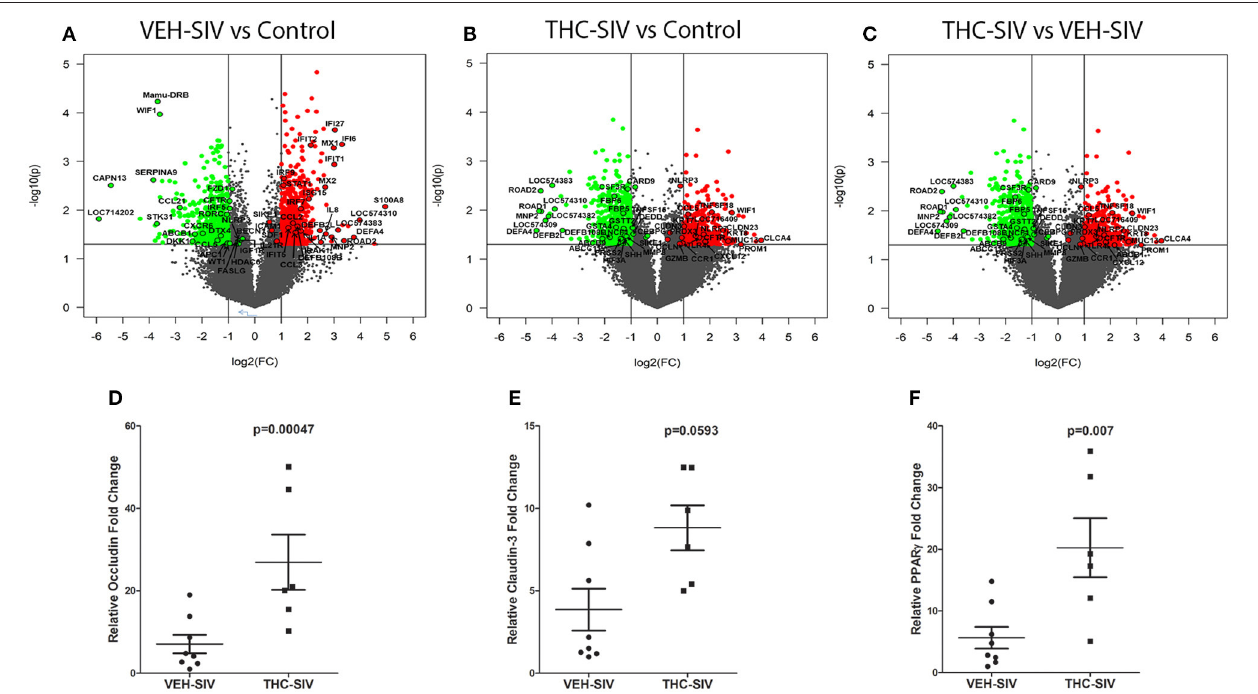
FIGURE 2 | Changes in mRNA expression in the whole colon tissue of chronically SIV-infected rhesus macaques administered vehicle (VEH) or delta-9-tetrahydrocannabinol ( 1 9 -THC). Volcano plot shows the relationship between fold-change (X-axis) and statistical significance (Y-axis) of differentially expressed mRNAs in VEH/SIV (A) and THC/SIV (B) rhesus macaques relative to controls and in THC/SIV relative to VEH/SIV rhesus macaques (C) . The vertical lines in (A–C) correspond to 2.0-fold up and down, respectively, and the horizontal line represents p ≤ 0.05. The negative log of statistical significance ( p-value ) (base 10) is plotted on the Y-axis, and the log of the fold change base (base 2) is plotted on the X-axis. All differentially expressed mRNAs listed in Supplementary Tables 5 – 10 are listed and highlighted with a black outer border in (A–C) . RT-qPCR confirmation of OCLN (D) , CLDN3 (E), and PPAR γ (F) mRNA expression in the jejunal epithelium of THC/SIV compared to VEH/SIV rhesus macaques. The RT-qPCR analysis was performed twice, and the data were analyzed using the non-parametric Wilcoxon’s rank sum test for independent samples. The error bars represent standard error of mean fold change within each group.